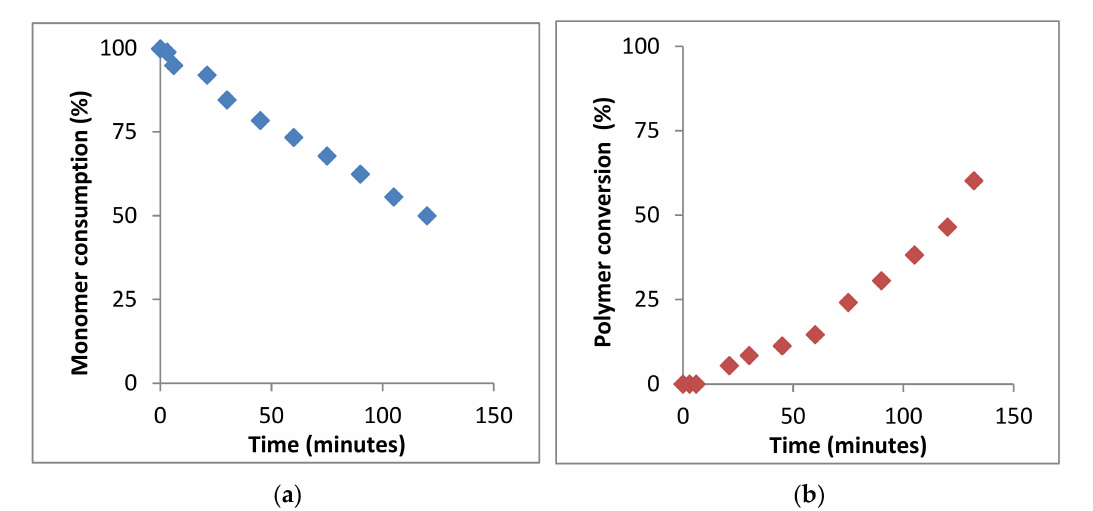
Figure 4. Kinetics of bulk polymerization of BMA at 60 ◦ C, determined by 1 H-NMR spectroscopy. ( a ) Monomer consumption and ( b ) polymer